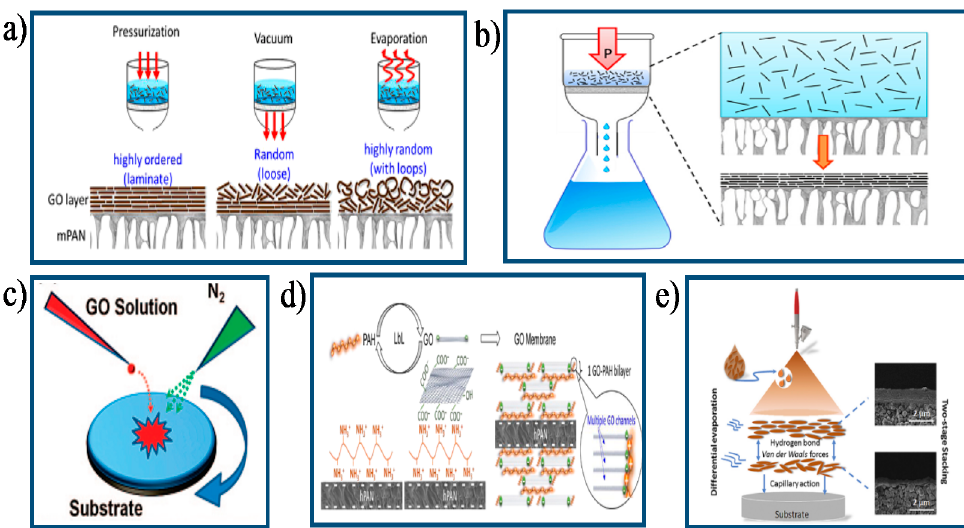
Figure 4. Schematic diagrams of the preparation of GO-based membranes through different approaches: ( a ) filtration-assisted self-assembly and evaporation-assisted self-assembly technique